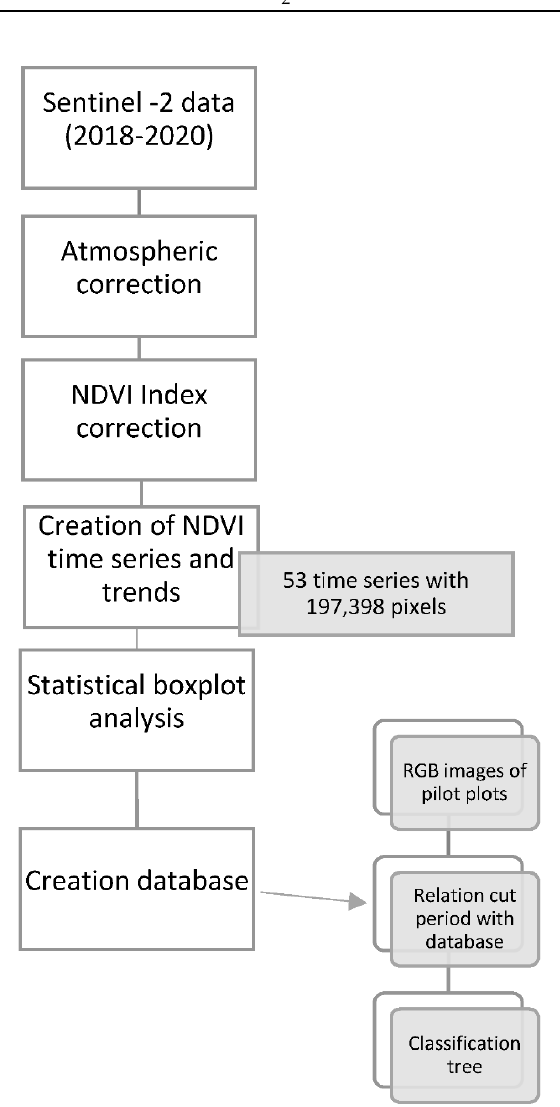
Figure 5. Summarizing diagram of the methodology carried